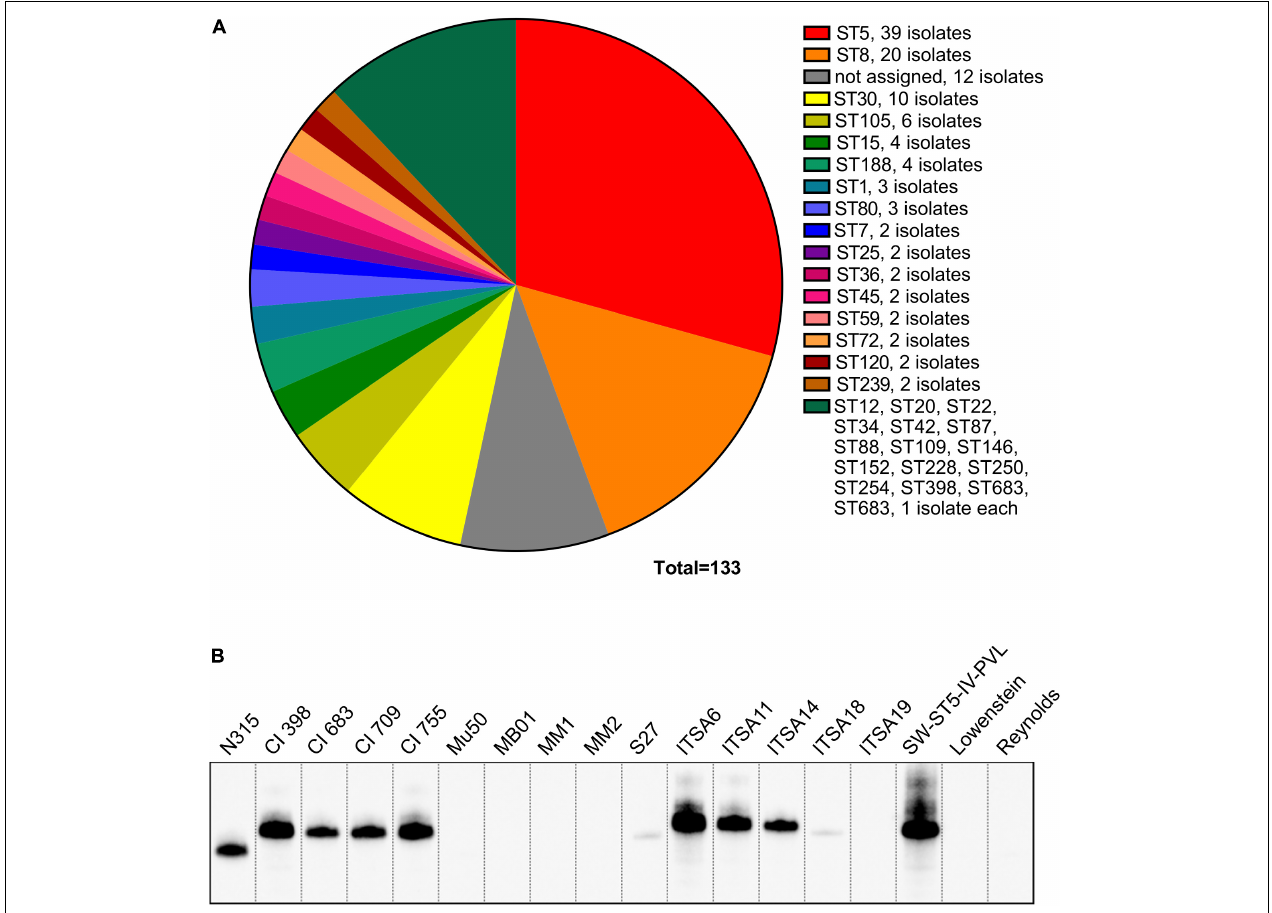
FIGURE 1 | SpA expression screening in a large panel of strains. (A) Lineages represented in the S. aureus collection. The majority of the strains belong to CC5 and CC8 lineages. (B) SpA expression in a representative panel of strains. Western blot analysis on the SpA - strains and the representative panel of SpA + strains. Samples were taken from the exponential phase of in vitro grown cultures, SpA was detected by direct binding with rabbit anti-mouse antibody conjugated to HRP. Western blots on cell wall preparations stained with anti-SpA chicken antibody having specificity for SpA, and anti-mouse rabbit antibody conjugated to HRP capable of binding to all Ig-binding proteins, reveal similar signals (data not shown) and indicate that SpA is the only Ig-binding protein detected in these fractions.